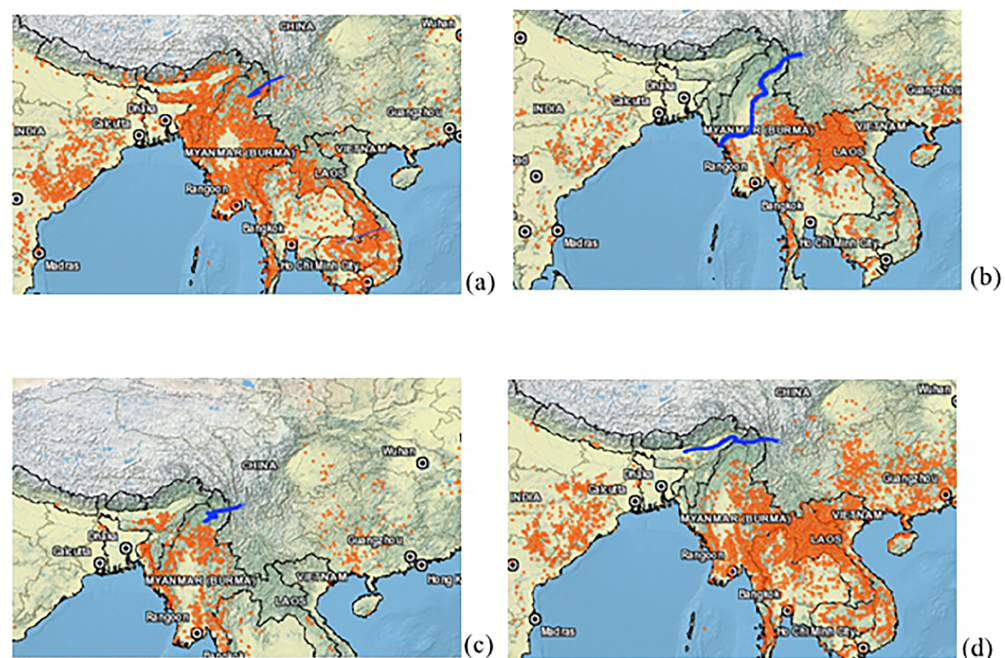
Figure 7. Occurrence of wildfires derived from MODIS images and back trajectories (blue lines) from the WRF model for the (a) first biomass burning event during 22–30 March, (b) the second biomass burning event during 5–6 April and the (c) third biomass burning event during 11–12 April. (d) Background: 1–4